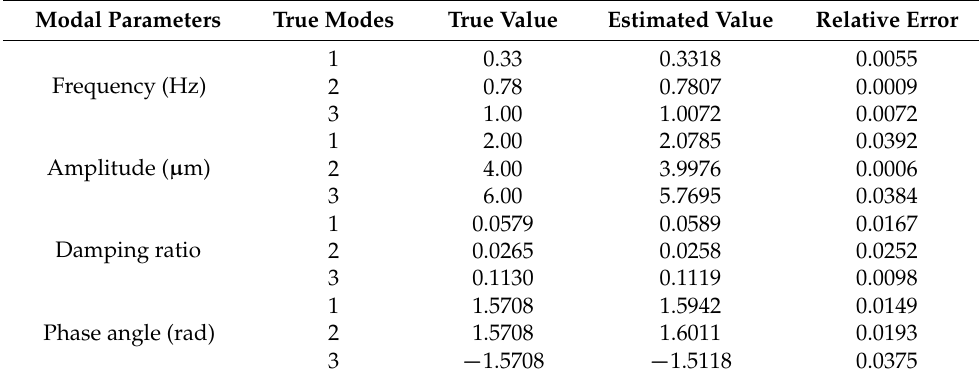
Table 5. Comparison of estimated modal parameters of SMPI with true modal parameters. Modal Parameters